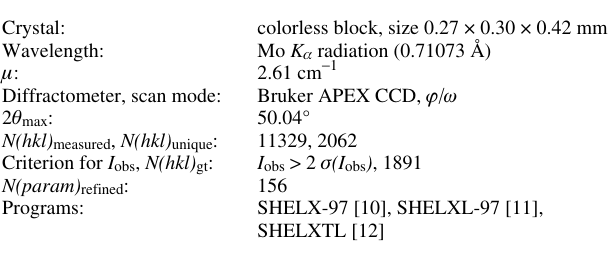
Table 1. Data collection and handling.